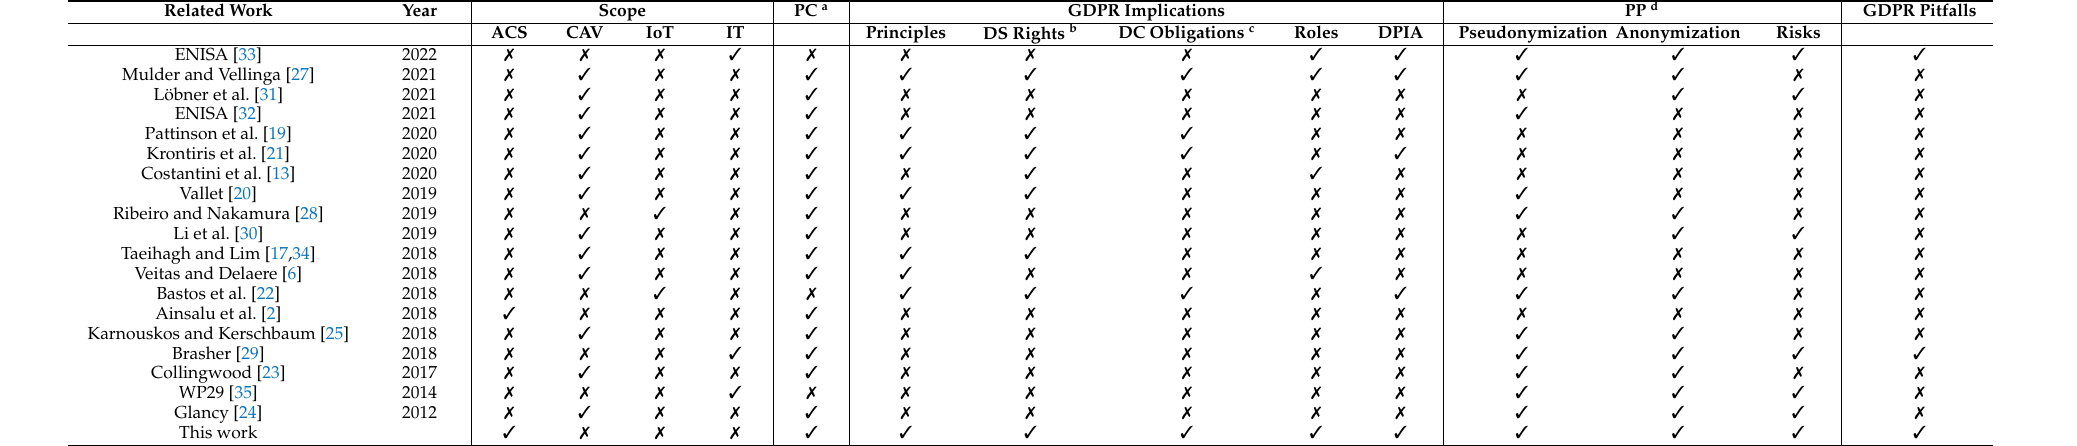
Table 1. Related work